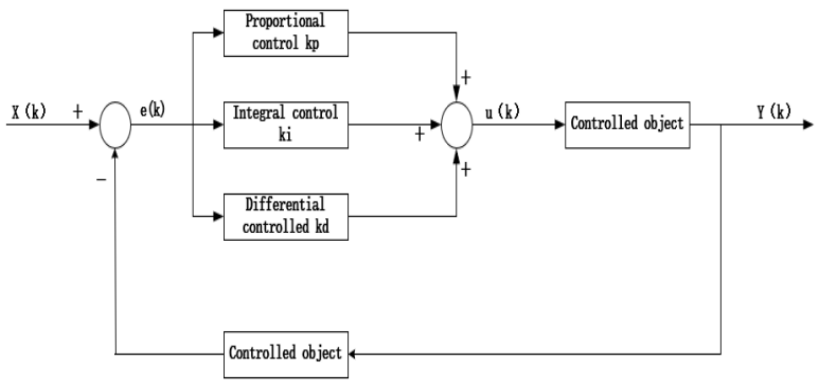
Figure 10. PID controller block diagram.